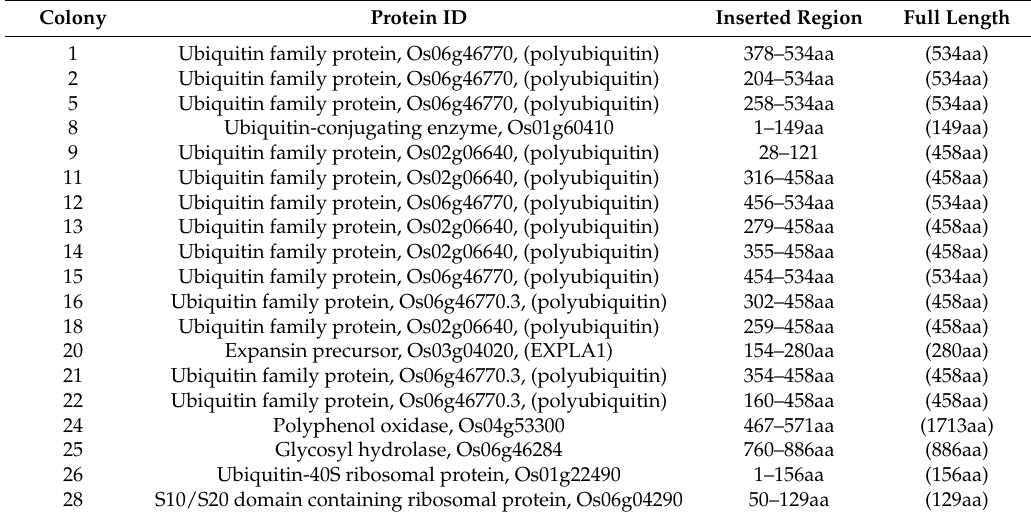
Table 1. List of GW2-interacting proteins that were isolated by yeast two-hybrid screening. Colony